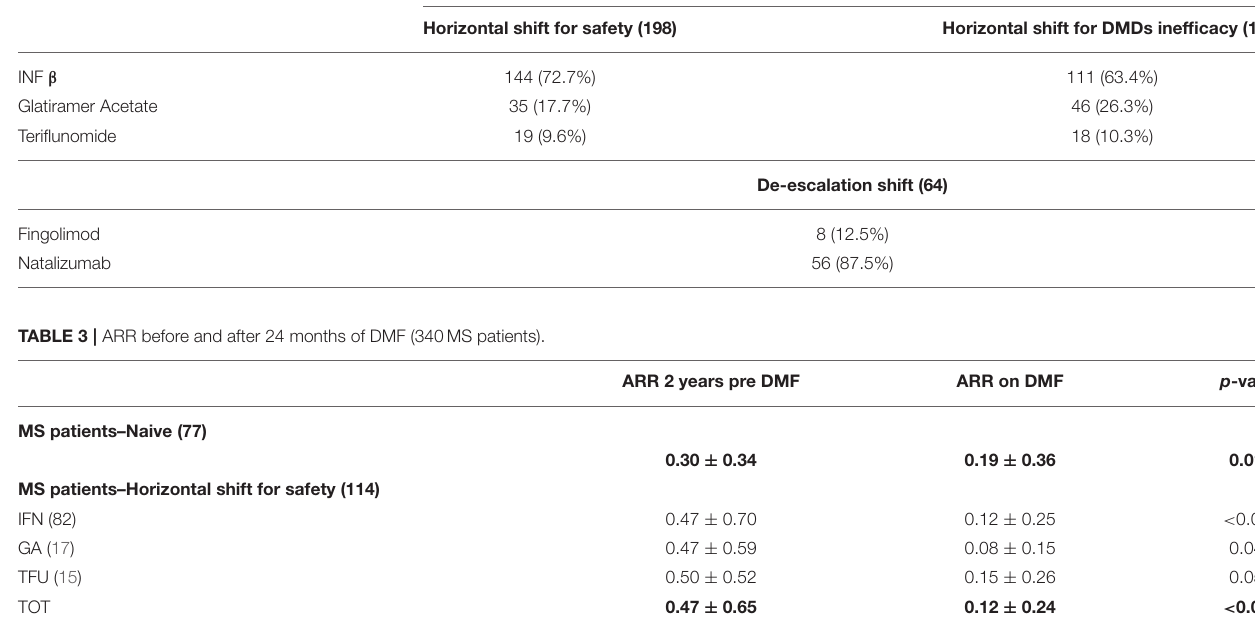
TABLE 2 | DMDs treatment before dymetilfumarate initiation in relation to the type of therapeutic shift performed.